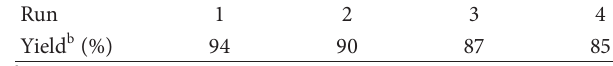
Table 3: Recycle study of ZnO